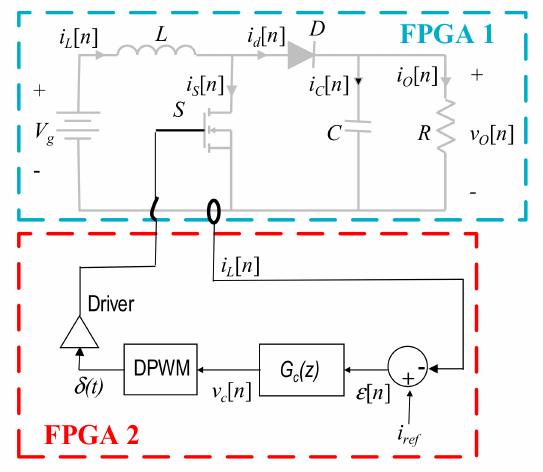
Figure 6. Schematic of the closed loop system.